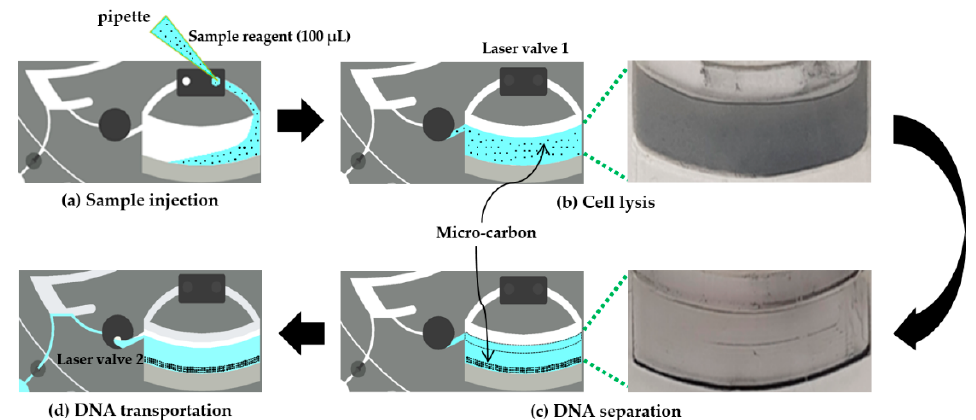
Figure 5. Micro-carbon-activated cell lysis for DNA extraction from the sample solution. ( a ) Sample injection: the sample solution containing micro-carbon is injected through the inlet hole. ( b ) Cell lysis: laser valve 1 is closed, and subsequently, the cell-lysis chamber is heated for 10 min. ( c ) DNA separation: DNA is centrifugally separated from the debris and micro-carbon at 11,000 rpm for 5 min. ( d ) DNA transportation: laser valve 2 is opened and, subsequently, the supernatant (approximately 5 µ L of DNA) flows to the next chamber (the amplification chamber) as the LOD